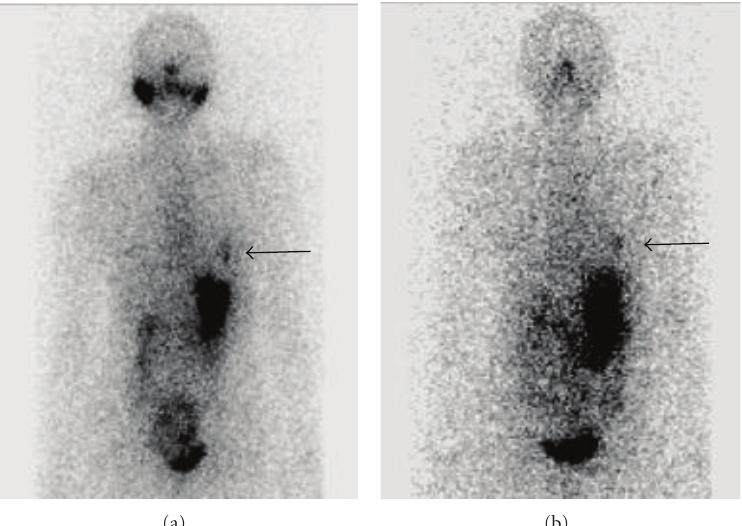
Figure 3: Follow-up diagnostic I-123 TSH-stimulated whole-body scan (anterior views) performed one year (a) and two years (b) after thyroid remnant ablation showing persistent uptake in the left